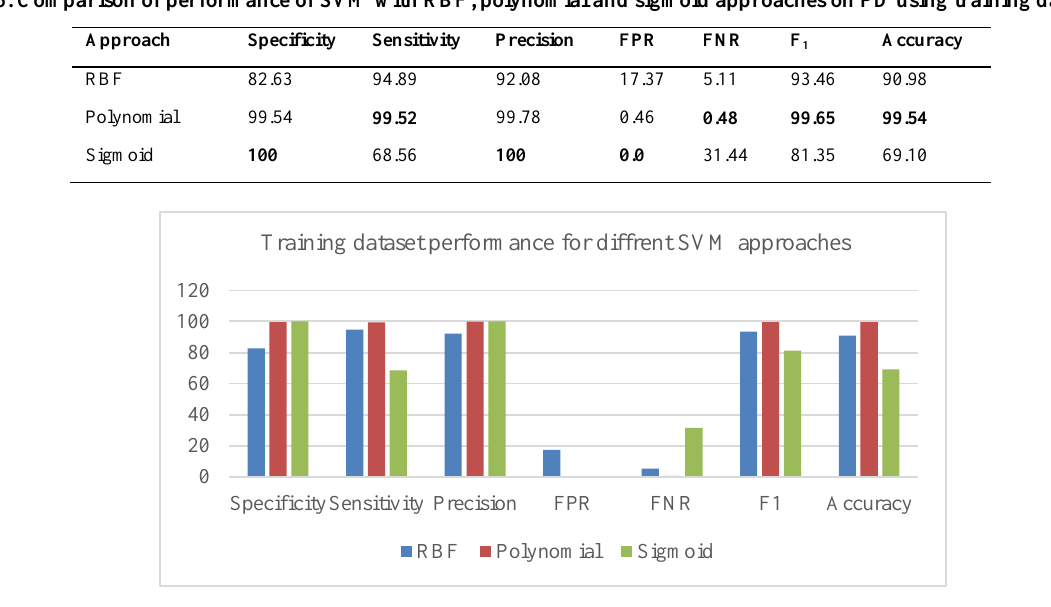
Table 5. Comparison of performance of SVM with RBF, polynomial and sigmoid approaches on PD using training data (%).